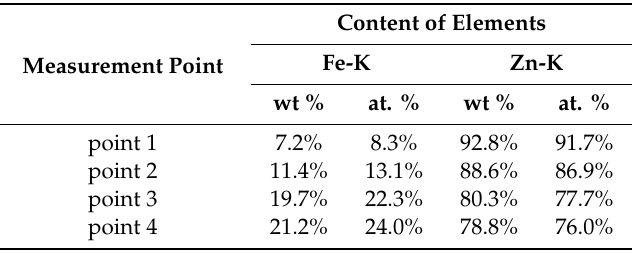
Table 1. Chemical composition at selected micro-areas of coating obtained on high-strength grade 10.9 bolts (measurement points acc. to Figure 3).